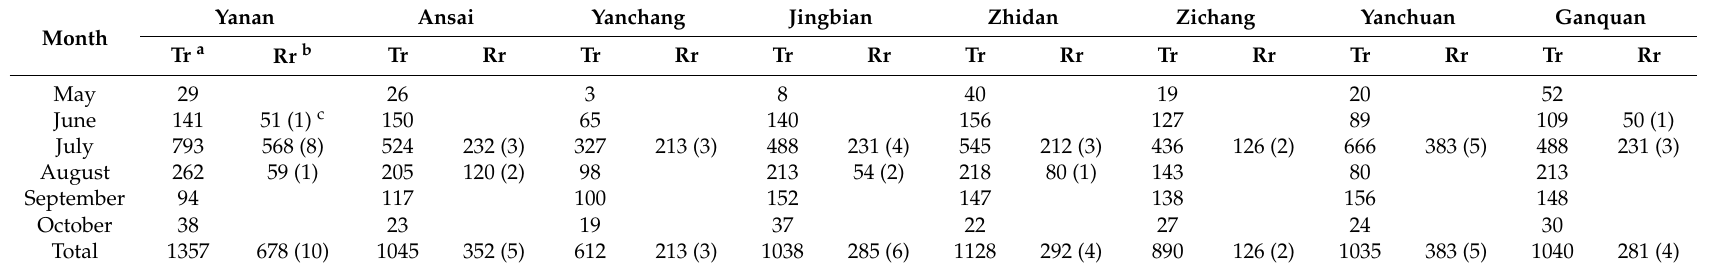
Table 3. Rainfall characteristics of the eight meteorological stations from May to October of 2013 in the Yanhe